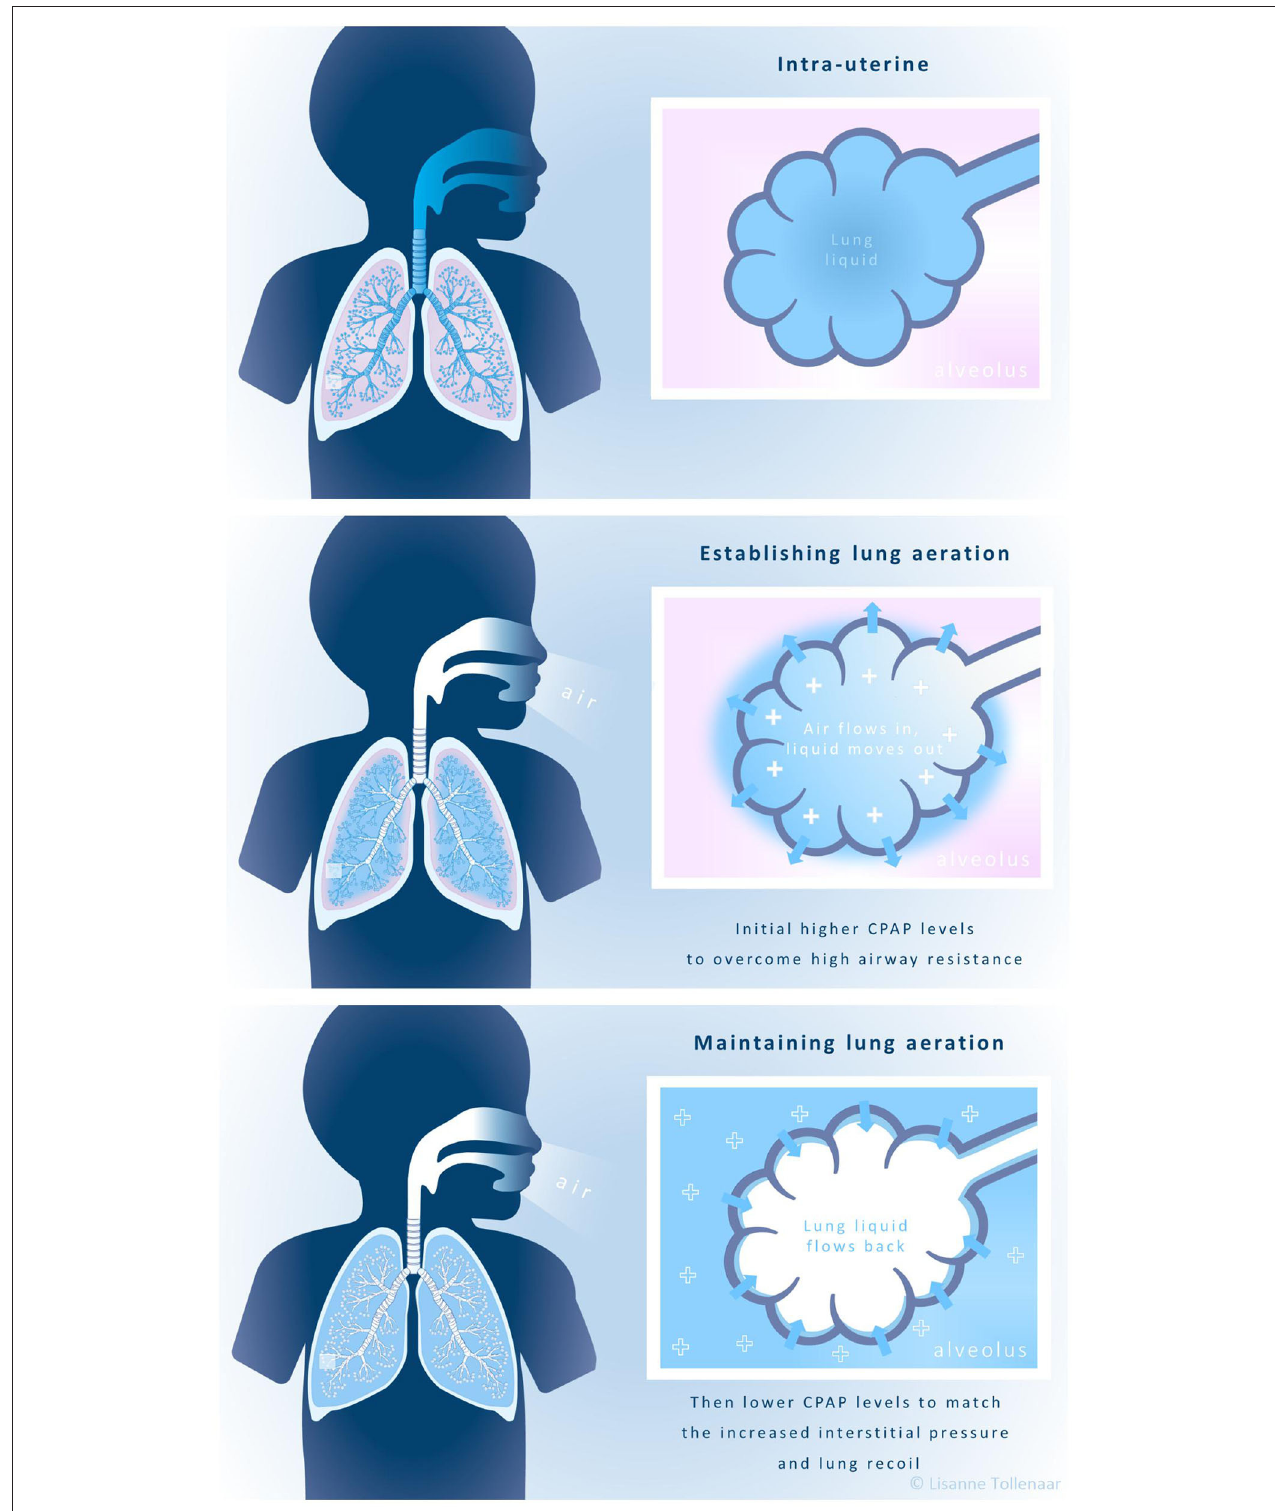
FIGURE 1 | Physiological-based